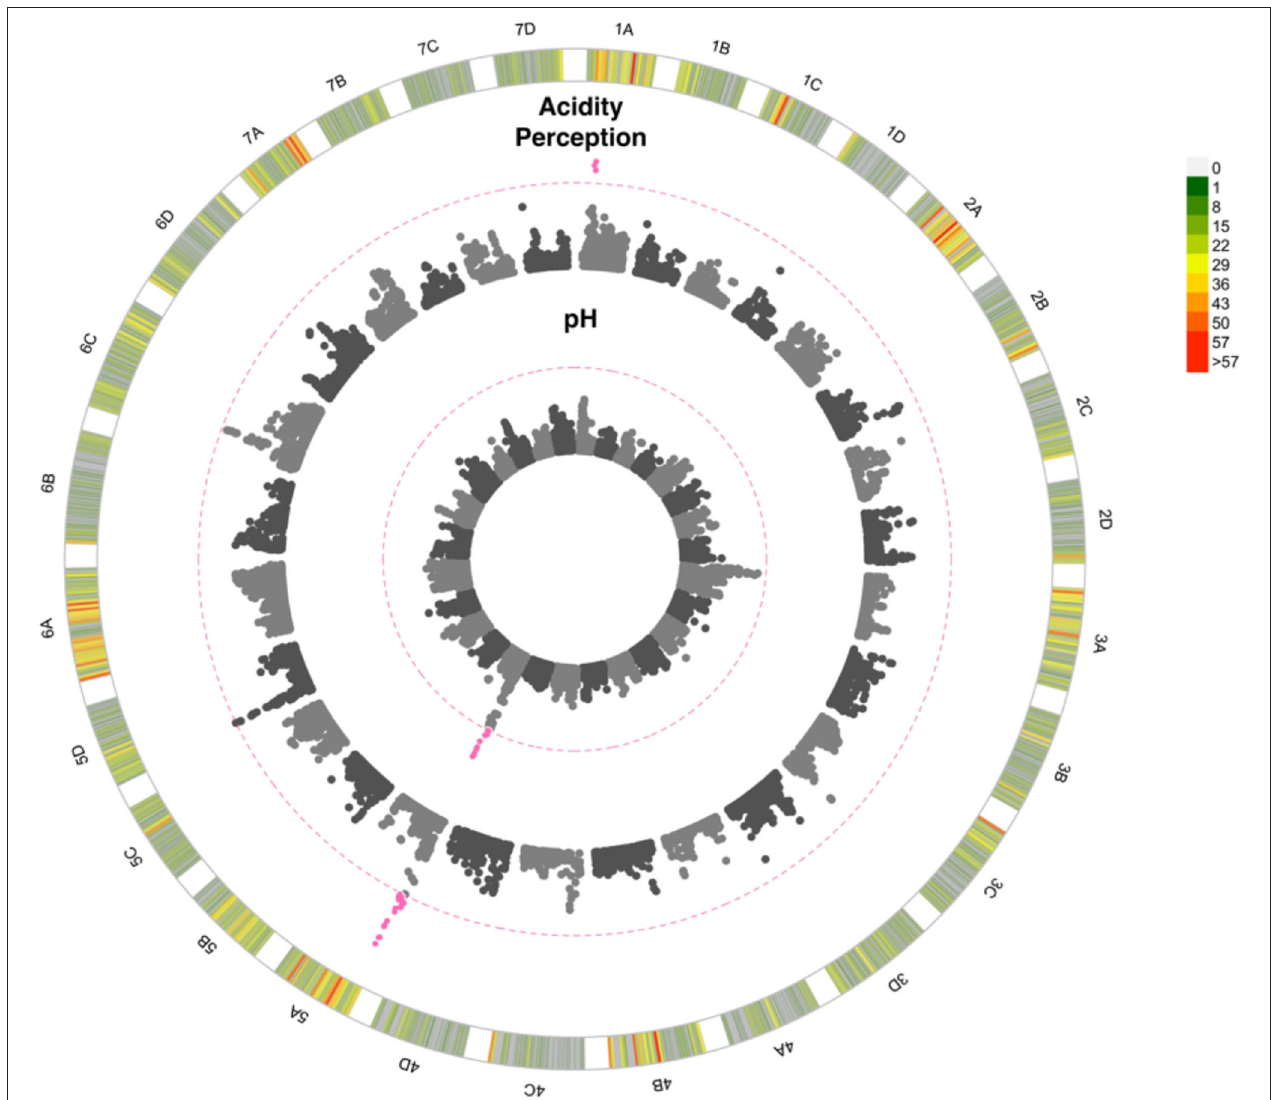
FIGURE 5 | Manhattan plot of GWAS looking at the association between SNPs and strawberry acidity. 1A to 7D represent the 28 chromosomes of the strawberry genome. The inner Manhattan plot represents acidity perception, the outer plot represents pH. The pink dotted line represents Bonferroni correction at –log10 p = 7.14 pink points are those which pass the significance threshold. Marker positions are scaled to the Fragaria vesca genome v.4 (Li et al., 2019). The colour-coded key in the outermost circle represents the number of SNPs segregating at each point across the